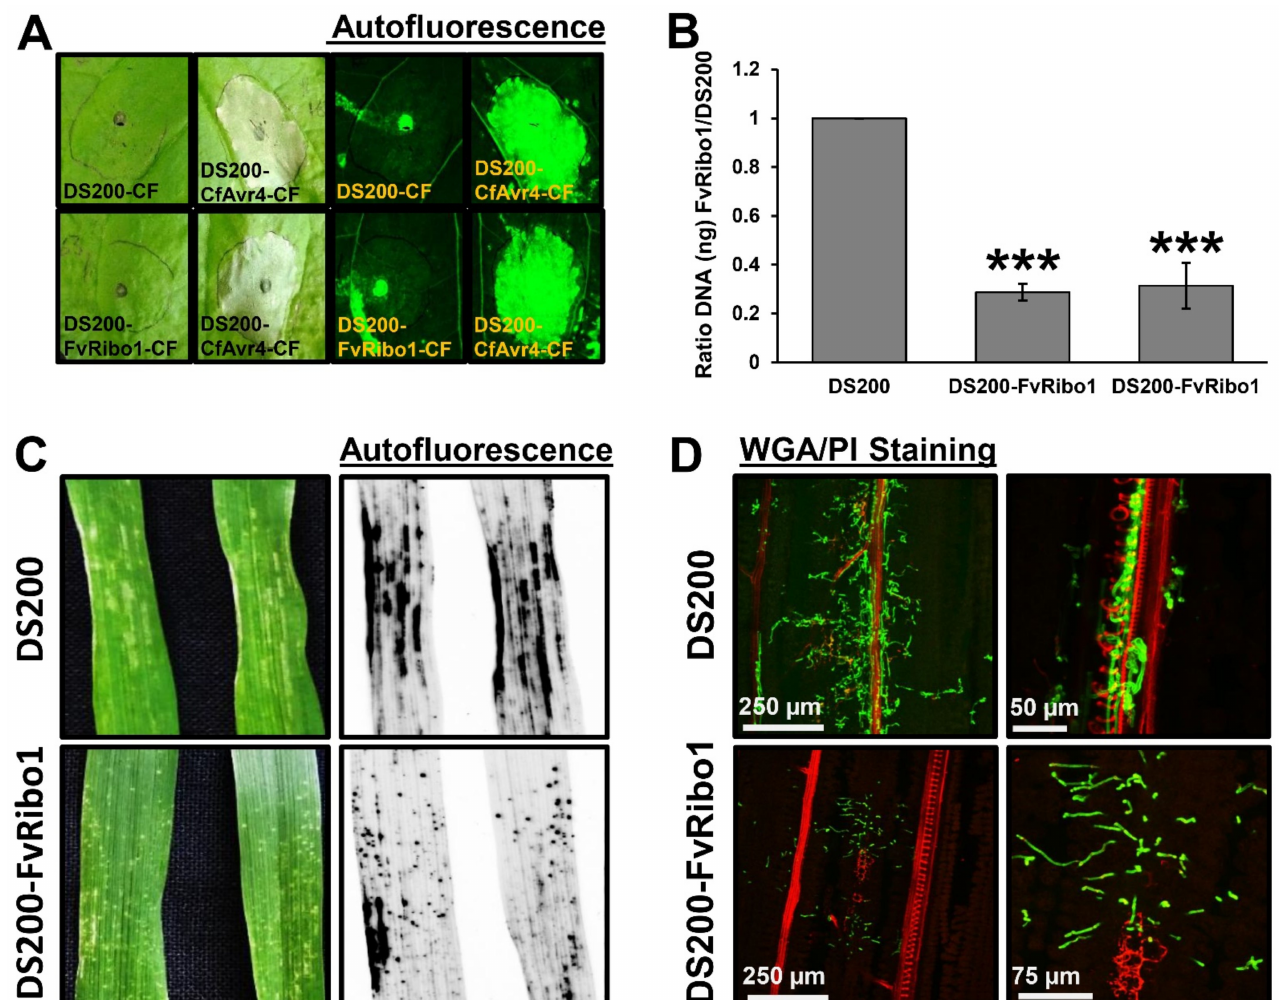
Figure 4. Heterologous expression of fungal effectors in Ustilago hordei . ( A ) Heterologous expression and secretion of CfAvr4 in U. hordei DS200 strain in vitro. U. hordei strain DS200 expressing CfAvr4 of Cladosporium fulvum with UHOR_02700 signal peptide and under the control of pActin promoter (for constitutive expression), as well as FvRibo1 of Fusarium verticillioides with UHOR_02700 signal peptide and under the control of pUHOR_02700 promoter (for expression in planta only) were grown in YEPS light liquid medium till OD:1.0. The U. hordei cell suspensions were centrifuged and the culture filtrates (CF) of each sample were infiltrated into tobacco leaves expressing Cf4-resistant protein, which can recognize CfAvr4 and induce cell death by means of hypersensitive response (HR). The culture filtrates from U. hordei DS200 and DS200-FvRibo1 strains were used as negative controls. Pictures were taken at 5 days post infiltration (dpi). Autofluorescence of infected leaves was imaged to more easily see sites of cell death by using Gel-Doc (Bio-Rad). ( B ) Biomass quantification of DS200-FvRibo1 in barley leaves. The virulence of the U. hordei DS200 and two independent DS200-FvRibo1 strains was assessed by fungal biomass quantification from DNA isolated from infected barley leaves at 6 days post inoculation (dpi). The Ppi1 gene of U. hordei was used as a standard for qPCR. The fungal biomass was deduced from a standard curve. A student t-test was performed to determine significant differences, which are indicated as asterisks (***, p < 0.001). Error bars represent the standard deviation of three biological repeats. ( C ) Heterologous expression and secretion of FvRibo1 in U. hordei strain DS200 in planta. Ustilago hordei strain DS200 and DS200 expressing FvRibo1 (encoding a secreted ribotoxin) of Fusarium verticillioides with UHOR_02700 signal peptide and under the control of the UHOR_02700 promoter (for only in planta expression) were inoculated on susceptible 12-day-old barley seedlings. Macroscopic pictures were taken at 6 dpi. Autofluorescence pictures were taken to see better cell death by using Gel-Doc (Bio-Rad). ( D ) Wheat germ agglutinin (WGA)-AF488/propidium iodide (PI) staining was performed to visualize the colonization of DS200-FvRibo1 in barley leaves compared to DS200. While green signal indicates fungal colonization, the red signal represents the plant cell